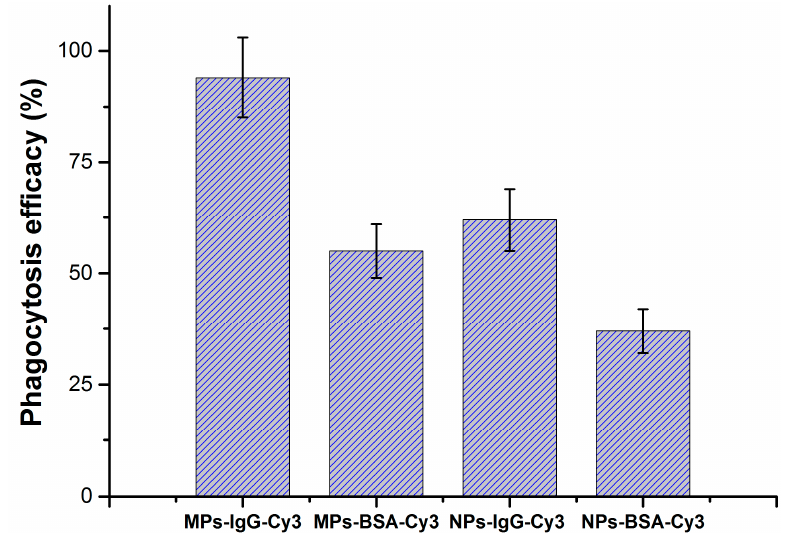
Figure 4. The effect of PLA particle size and IgG attachment on the percentage of macrophages derived from the peritoneal cavity of mice with internalized particles compared to the total number of macrophages.